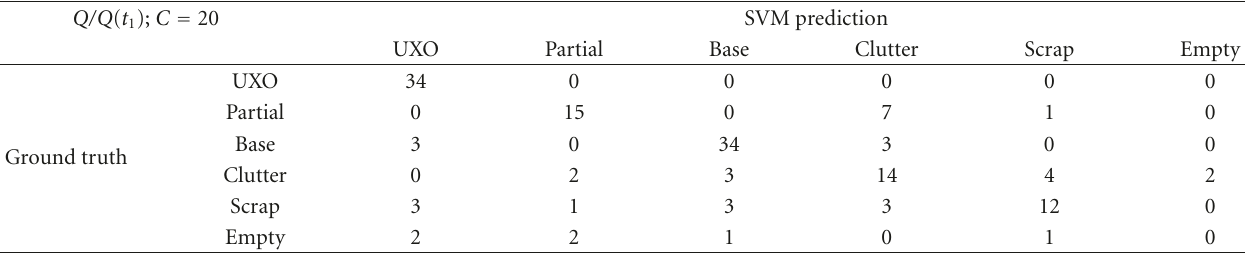
Table 4: SVM classification of Camp Sibert anomalies using all Q values (scaled by Q ( t 1 )) with C = 20.